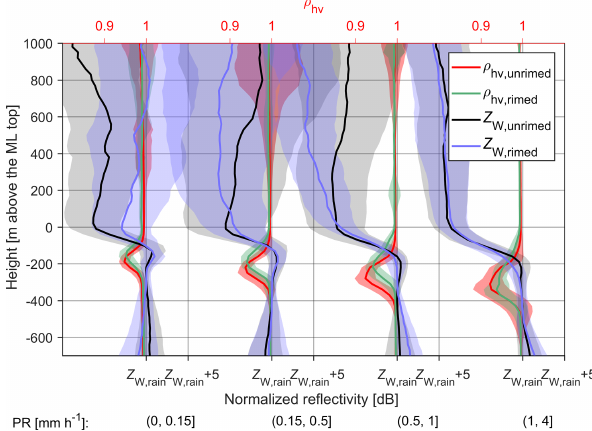
Figure 9. Same as Fig. 5 but for W-band. Note that the reflectivity profiles at W-band are shifted by matching the radar reflectivity at the ML bottom ( Z W , rain ), while the value of Z W , rain is not shown due to the unknown W-band